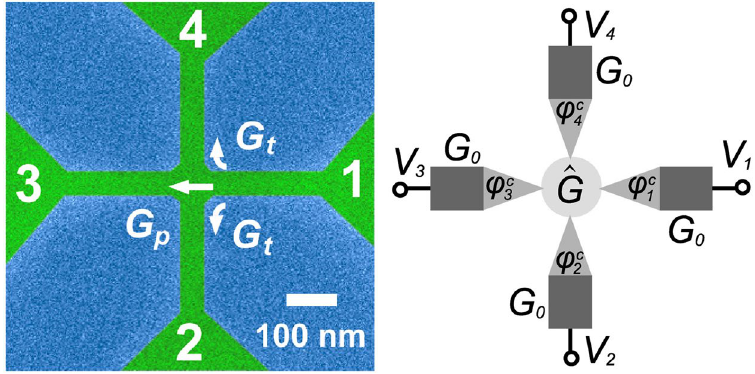
Figure 1. Left: False color scanning electron micrograph of the measured GNR sample; green color marks graphene and blue denotes the silicon oxide substrate. Terminals 1 and 3 were employed for cross correlation while bias was supplied via 2 and 4 in the HBT experiments. The white scale bar corresponds to 100 nm. The overlaid arrows define the straight and bent carrier paths with conductances of G and G in the central region, t p respectively, for electrons coming from terminal 1; the same definition of G and G repeats for electrons coming t p from each terminal. Right: Schematic illustration of our theoretical model with its most essential features: G 0 denotes the average arm conductance, G  describes the transport in the semiballistic central region, f ic and ϕ ic mark the non-equilibrium distribution and the local voltage at the contact point between the diffusive arm and the central region, and f E ( ) denotes the Fermi distribution. In the diffusive arm, the distribution function 0 varies as . For details, see